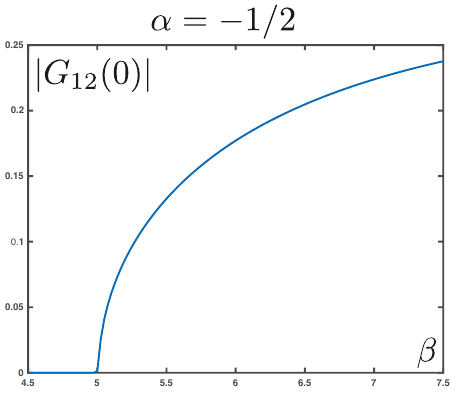
Figure 4 . The magnitude of the off diagonal correlator at τ = 0 , corresponding to the VEV of the operator c 1 i c † , plotted as a function of β (we use units where J = 1 ). A similar symmetry 2 i breaking behavior is observed for other values α < 0 or α > 1 .